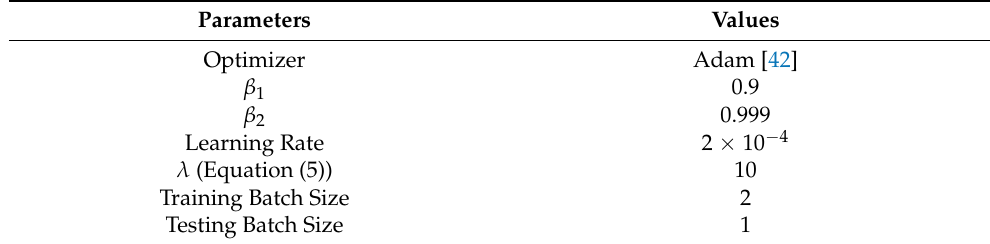
Table 1. Detailed configuration of the